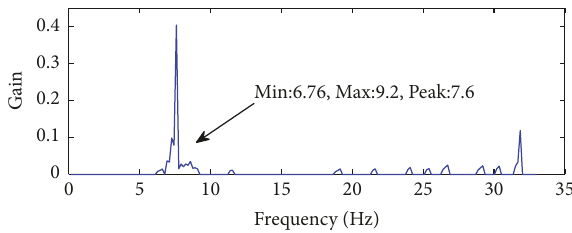
Figure 15: The frame frequency response characteristics.